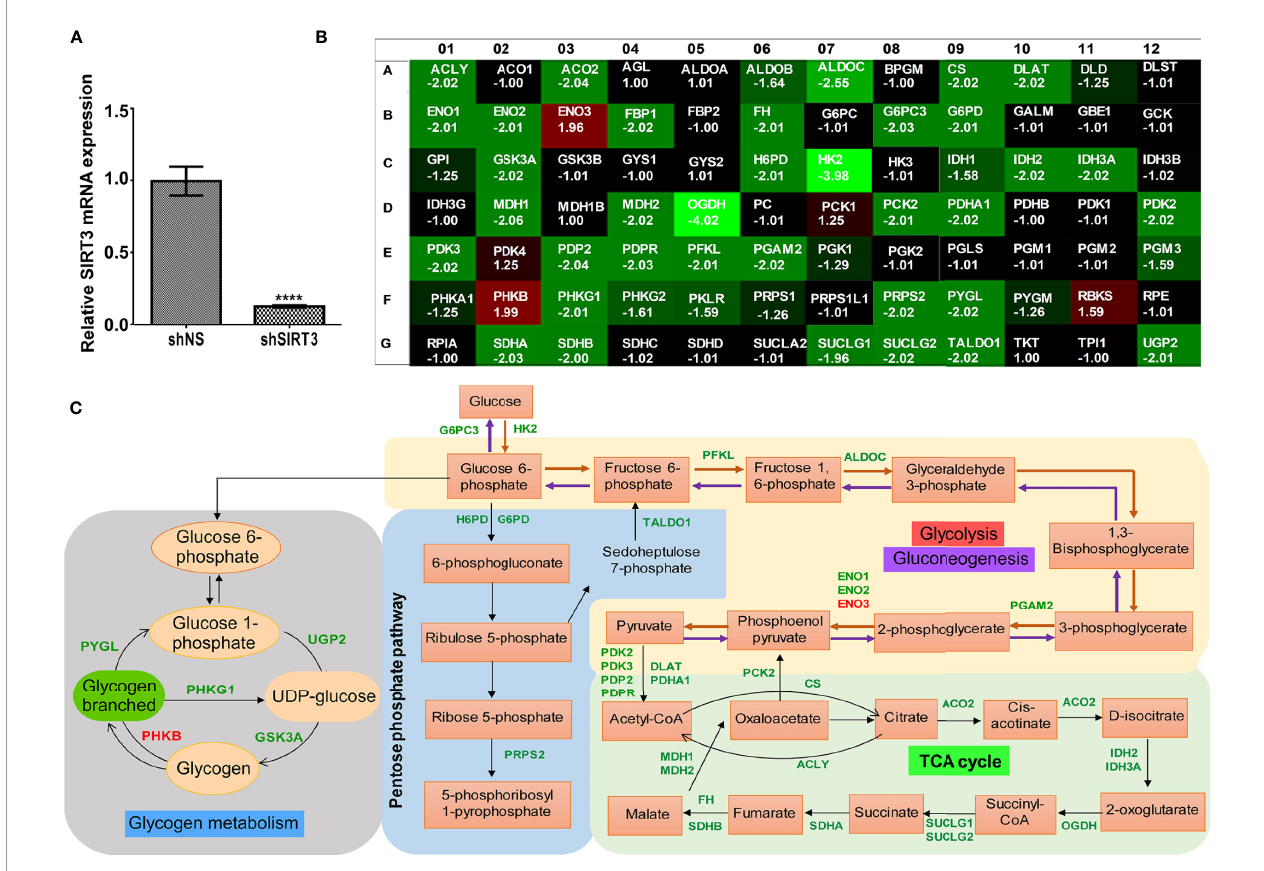
FIGURE 3 | Effect of SIRT3-knockdown on metabolism-related gene expression in SK-MEL-2 human melanoma cells. (A) RT-qPCR analysis con fi rming SIRT3 knockdown in SK-MEL-2 cells. ACTB was used as an endogenous control. Data is presented as mean ± SEM (t-test, ****p < 0.0001). (B) Utilizing cDNA from SIRT3-knockdown (shSIRT3- SK-MEL-2) melanoma cell, Glucose metabolism PCR array was run and analyzed to assess the expression levels of 84 metabolism- related genes. Heat map of average gene expression in shSIRT3 SK-MEL-2 cells compared to shNS- SK-MEL-2 (control) is presented as fold change regulation. An increase in gene expression is depicted in red, whereas a decrease in gene expression is represented by green color. No differences in expression are depicted in black. (C) Signi fi cantly modulated genes showing ≥ 1.96-fold regulation were distributed accordingly to their contribution in different metabolic pathways. Fold changes were calculated using the DD Ct method. The values represent the average fold change of three independent